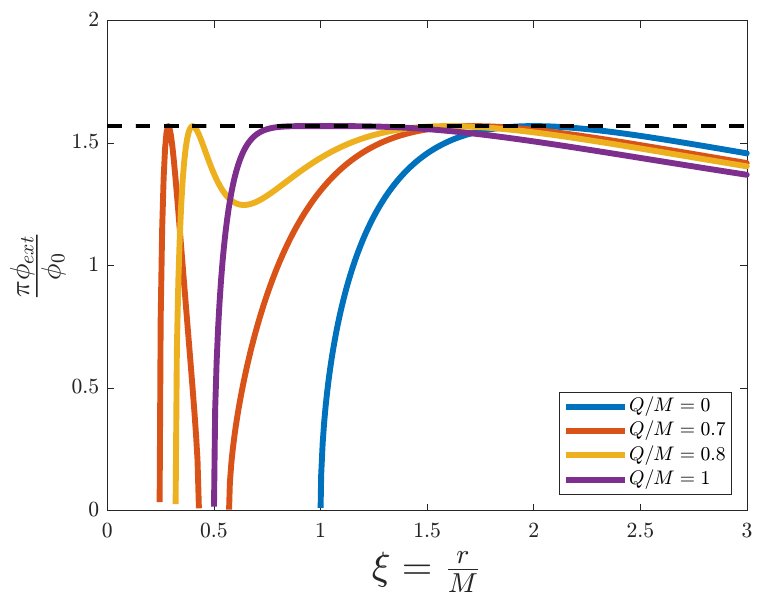
Figure 3. External magnetic flux πφ ext / φ 0 versus the adimensional distance ξ = r / M for the simulation of a Reissner–Nordstrøm black hole, for different values of A = Q / M . The dashed line represents the threshold value πφ ext / φ 0 = π